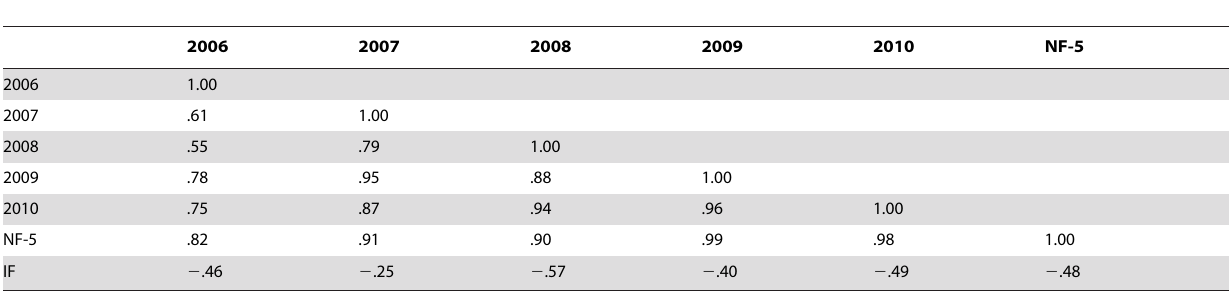
Table 3. Correlations Among 1-year N-pact Factors, 5-year N-pact Factors, and Citation Impact Factors across the Six Journals